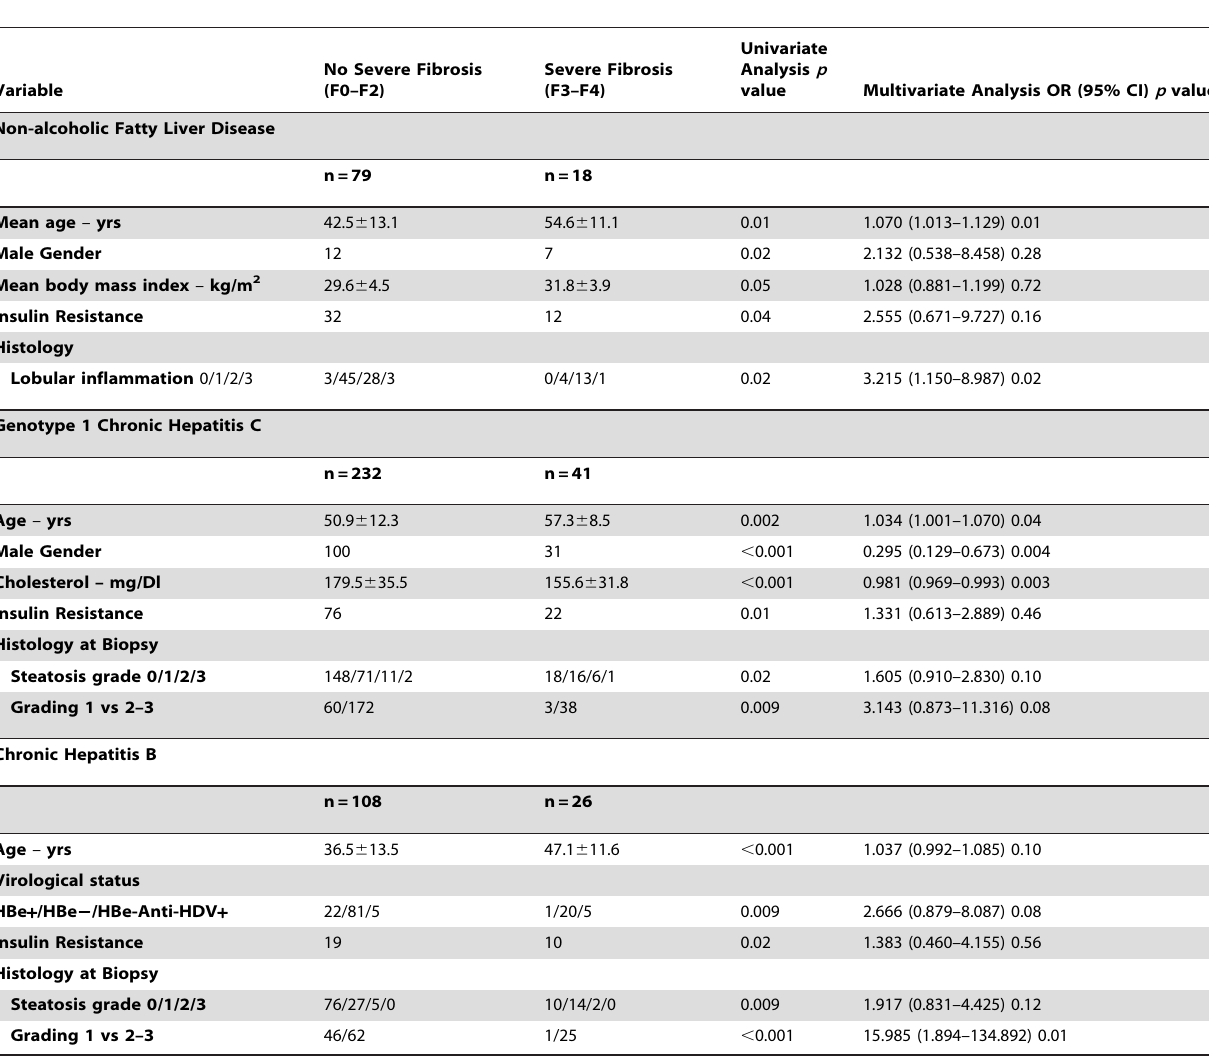
Table 4. Univariate and Multivariate Analysis of Risk Factors Associated with Severe Fibrosis (F3–F4) in 504 Patients with Metabolic and Viral Chronic Liver Disease and normal GGT values, by Logistic Regression